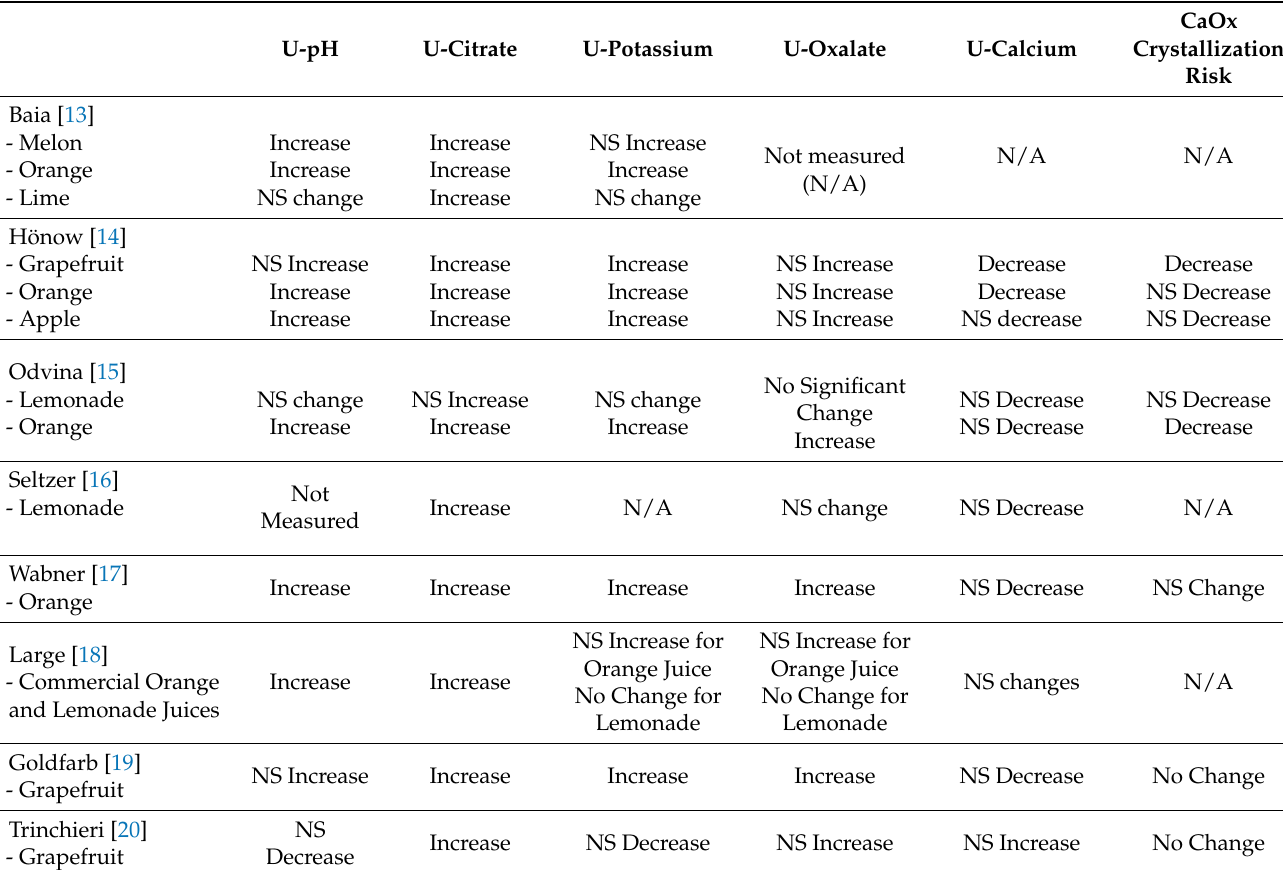
Table 2. Summary of the important urinary parameter changes in the reviewed articles (U—urine, N/A—not available). Changes are significant unless otherwise stated with NS (Non